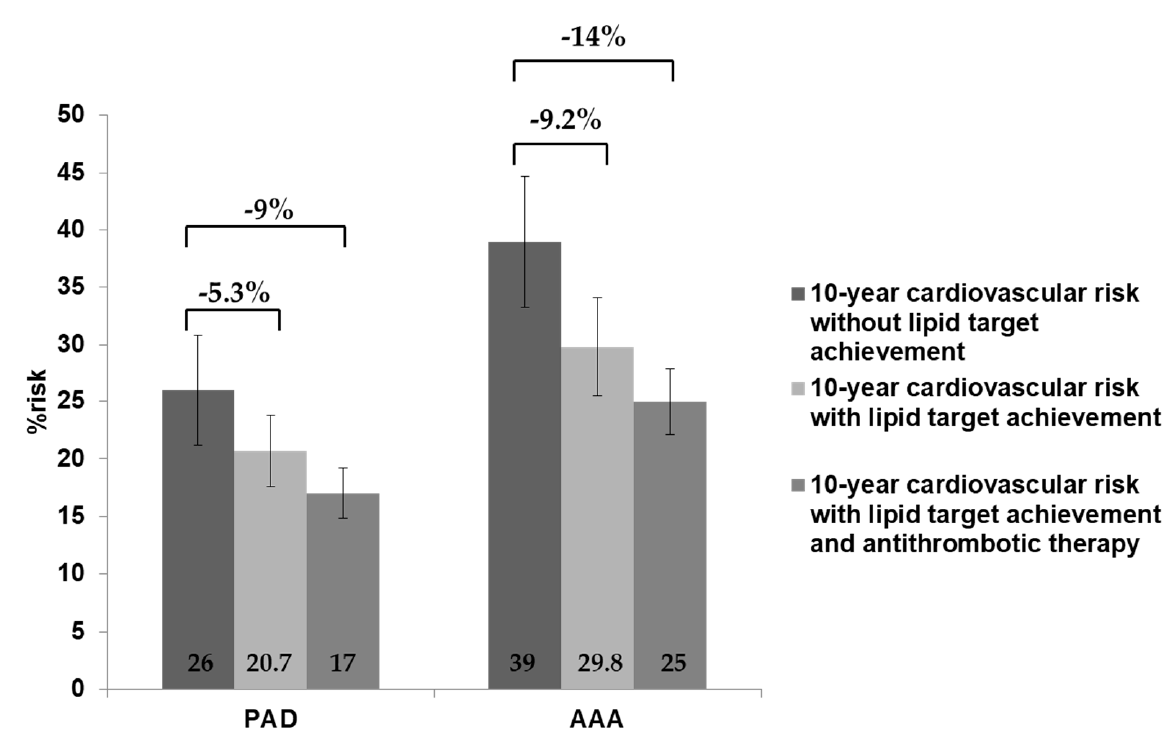
Figure 2. Mean 10-year cardiovascular risk estimation considering PAD or AAA alone: comparison of risk between the study population according to lipid profile and antithrombotic therapy.